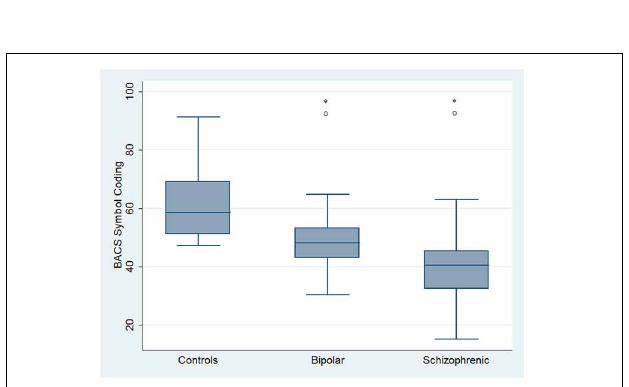
FIGURE 4 | Differences between groups in neuropsychological tasks: BACS symbol coding. ∗ Significantly different from HC ( p < 0 . 05). ◦ Significantly different from BD ( p < 0 . 05).